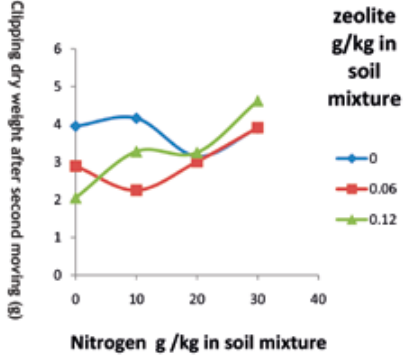
Fig. 4 - Effect of nitrogen and zeolite on clipping dry weight after second mowing (g) of Festuca arundinaceae Schreb‘Starlet’.